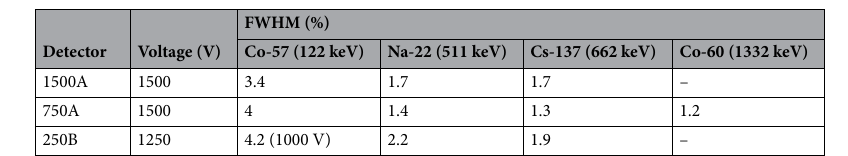
Table 3. FWHM of spectra from the reported sources acquired with the most performant detectors for each pixel dimension. The voltage in brackets is referred to a measure with a bias different from the one in the corresponding column. Measurements were carried out at 20 °C.